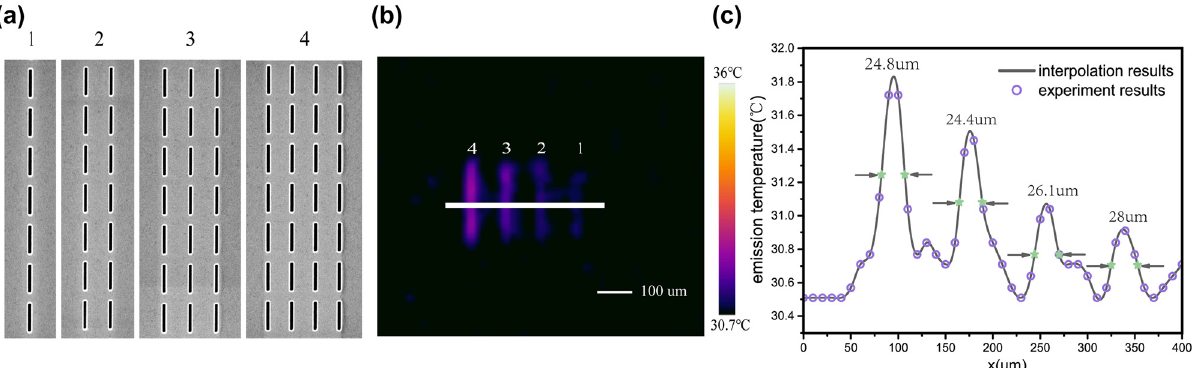
Figure 3: Spatially designed thermal emission based on wire-shaped meta-cavity patterns. (a) SEM top view of fabricated wire-shaped meta-cavity patterns. (b) The thermal image of fabricated patterns taken at 100 ◦ C. (c) The emission temperature distribution at the center of four samples. The purple circle presents the emission temperature directly obtained from thermal image. The gray solid line presents the emission temperature distribution obtained by